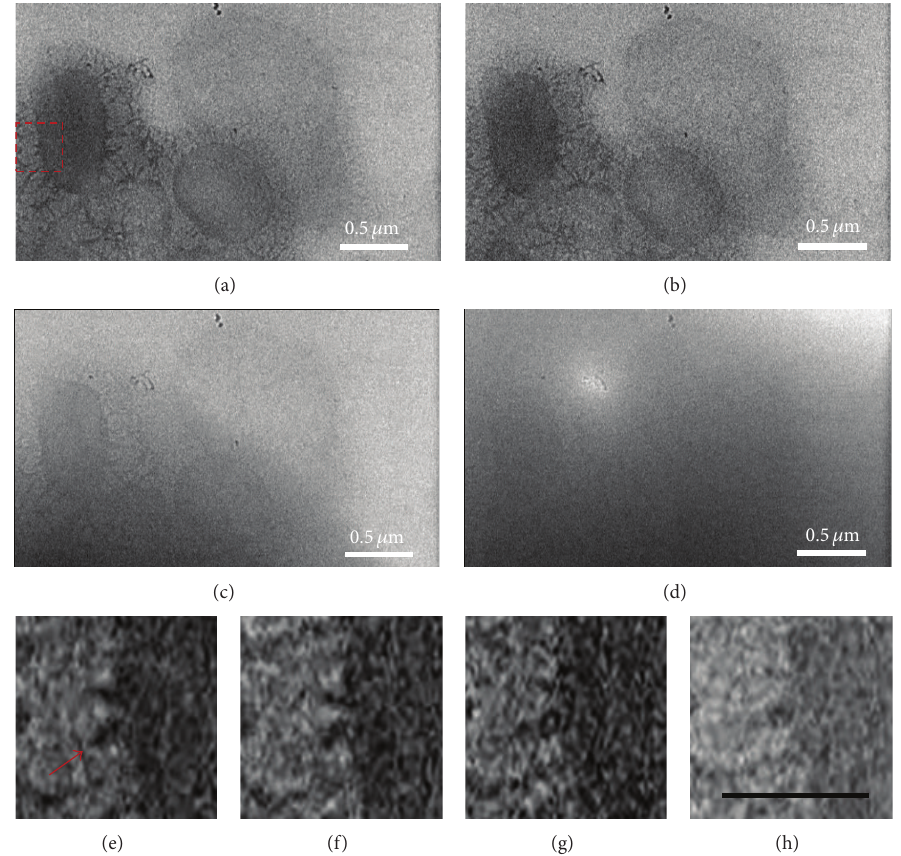
Figure 5: Video frames taken from the labeled region in Figure 1(a): (a) 0 s, (b) 2 s, (c) 40 s, and (d) 60 s. (e)–(h) Magnified video frames taken from the labeled region in Figure 5(a): (e) 0s, (f) 10s, (g) 20 s, and (h) 30 s. The arrow in (e) points to a pilus that changed shape with time. The scale bar in (h) is 0.2 𝜇 m.